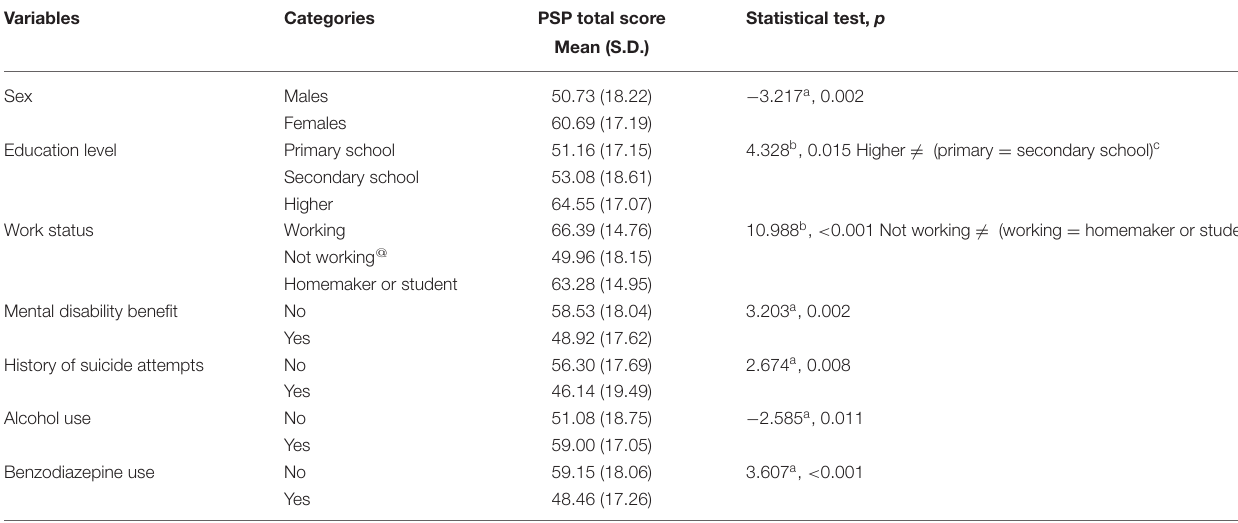
TABLE 3 | Statistically significant associations between PSP total score and independent (categorical)